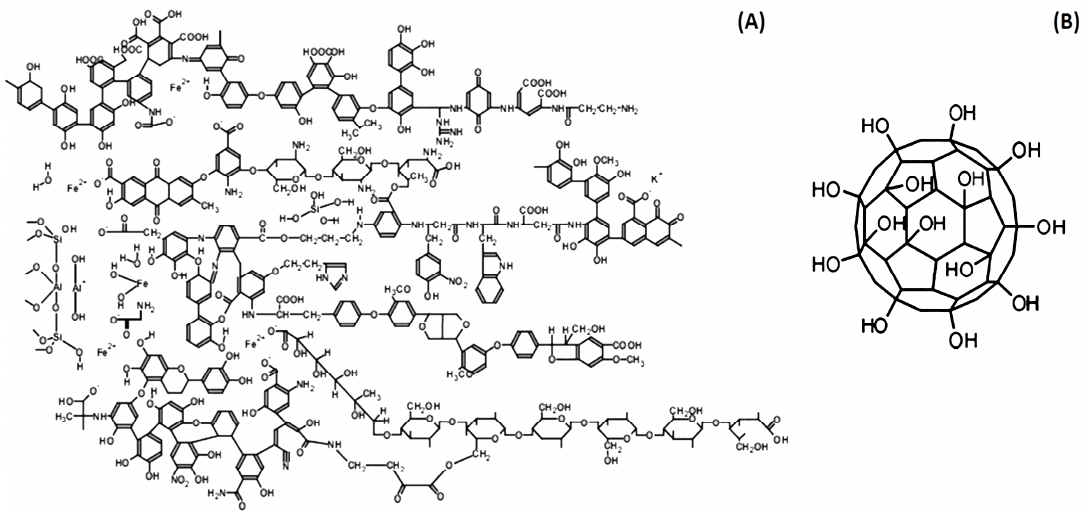
Figure 10. Hypothetical structure of bioactive compounds: ( A ) fragment of humic substances, ( B ) fullerenol C-60.